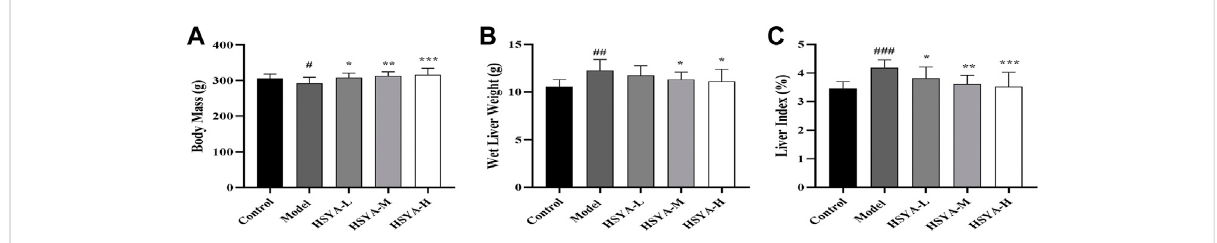
FIGURE 2 Effects of HSYA on Body Mass, Wet Liver Weight and Liver Index. (A) Body Mass; (B) Wet Liver weight; (C) Liver Index ( (cid:1) x ± s , n = 10). # p < 0.05, ### p < 0.001 vs. the control group; * p < 0.05, ** p < 0.01 vs. the model group.